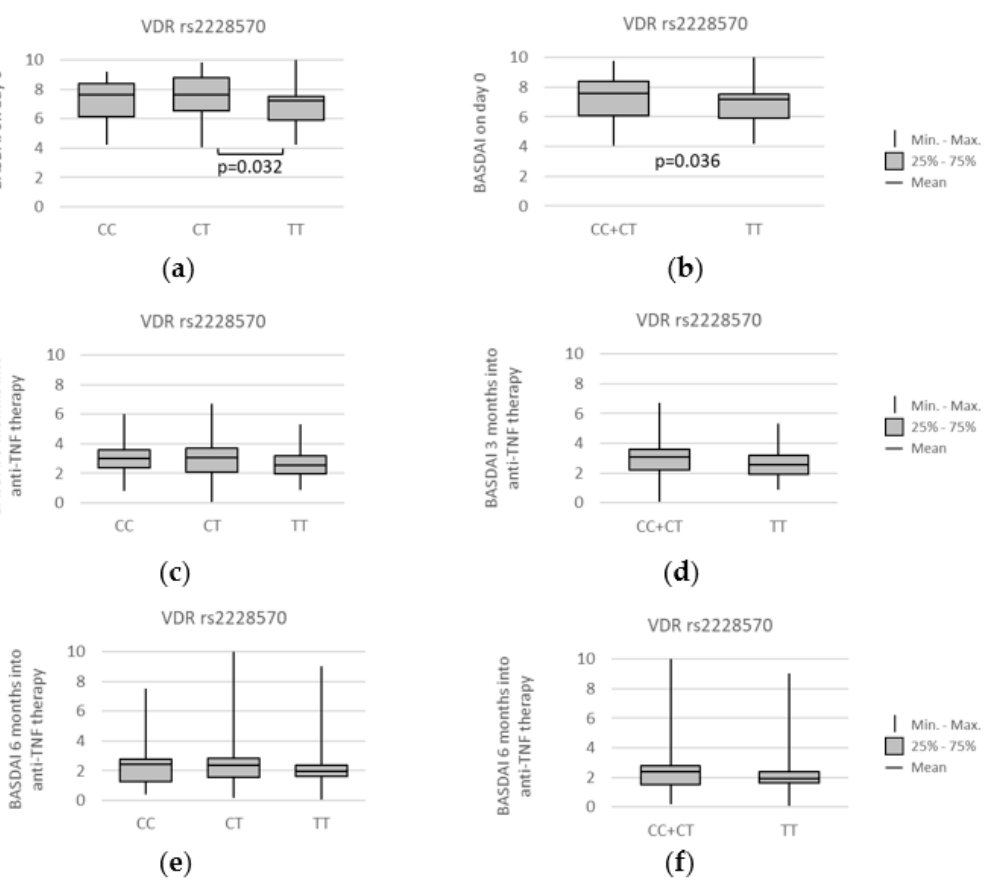
Figure 8. Relationships between VDR rs2228570 genotypes and BASDAI scores at different time points: ( a , b ) prior to anti-TNF therapy, ( c , d ) after 3 months, and ( e , f ) after 6 months of the treatment. The following statistically significant associations were found at day 0: ( a ) CT vs. TT , p = 0.032; and ( b ) CC + CT vs. TT , p = 0.036. Analysis was performed using unpaired two-sample Wilcoxon test.